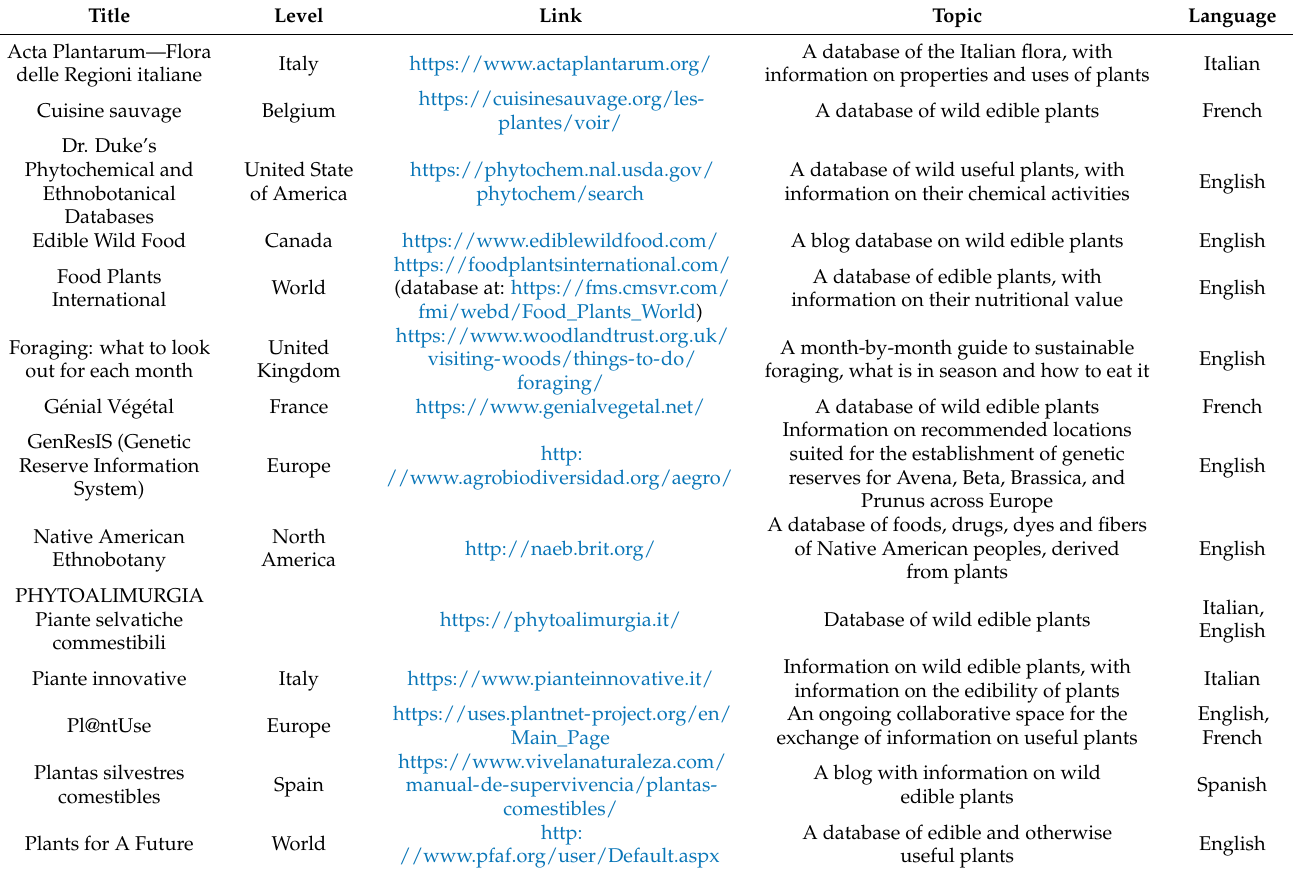
Table 1. Partial list of relevant WEP